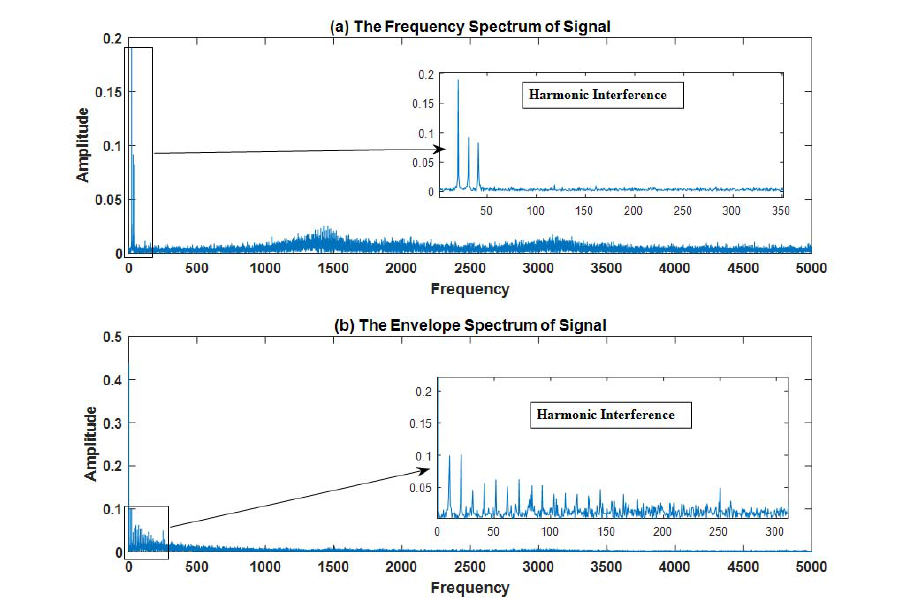
Figure 6. The simulated signal: ( a ) frequency spectrum; ( b ) envelope